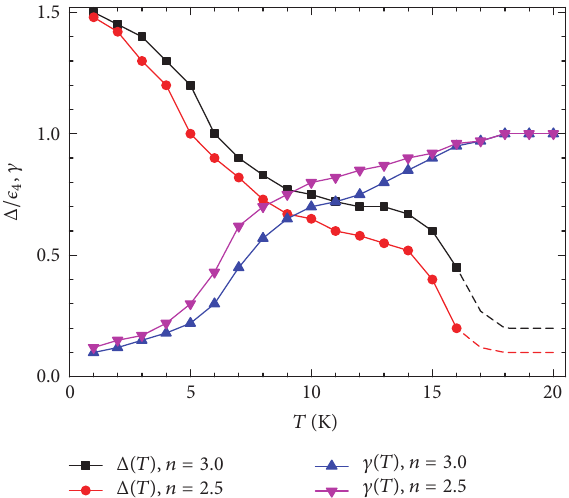
Figure 10: 𝛾(𝑇) and Δ(𝑇) dependencies as obtained using (11) for fitting the 𝜌(𝑇) data. Calculated curves correspond to the range of the exponent 𝑛 = 2.5 – 3.0 . The 𝛾 values are in arbitrary units. The Δ values are normalized to 𝜖 4